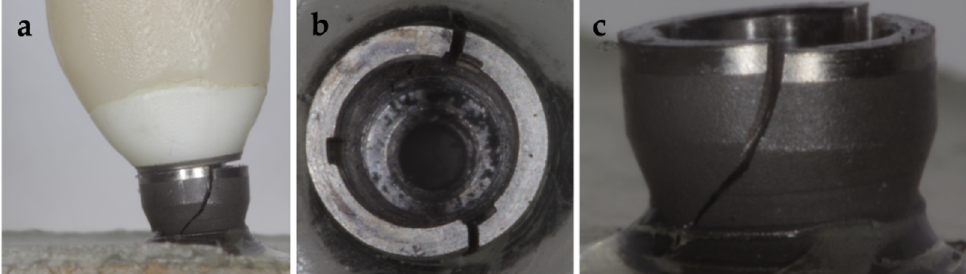
Figure 5. Representative image of the tube in tube internal connection specimen after the fatigue test showing fractures of the implant neck: ( a ) general view; ( b ) top view; ( c ) lateral view.